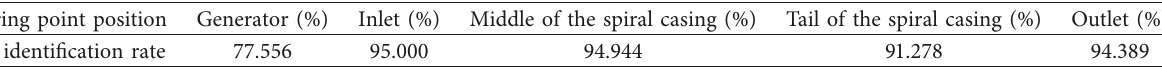
Figure 17: Identification rates of three units based on PSO-BP neural network. (a) Generator; (b) inlet; (c) middle of the spiral casing; (d) tail of the spiral casing; (e) outlet. Table 6: Identification rates of three units based on BA-BP neural